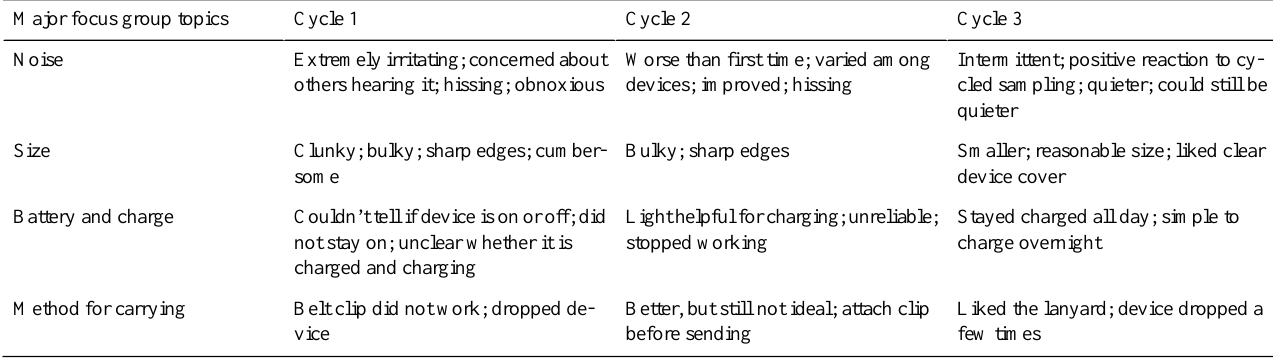
Table 1. Major thematic topics and comments from focus groups over 3 consecutive design-feedback iterative cycles for testing a personal air pollution